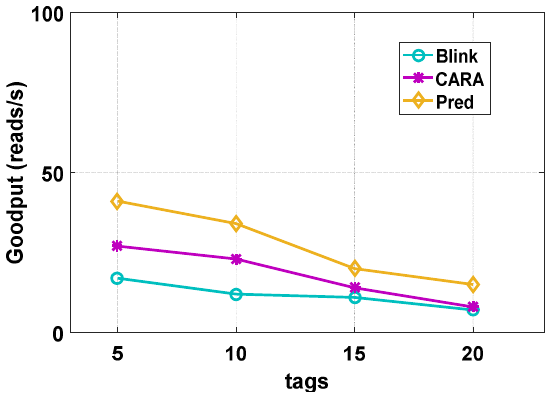
Figure 14. Unstable environment. Figure 14. Unstable